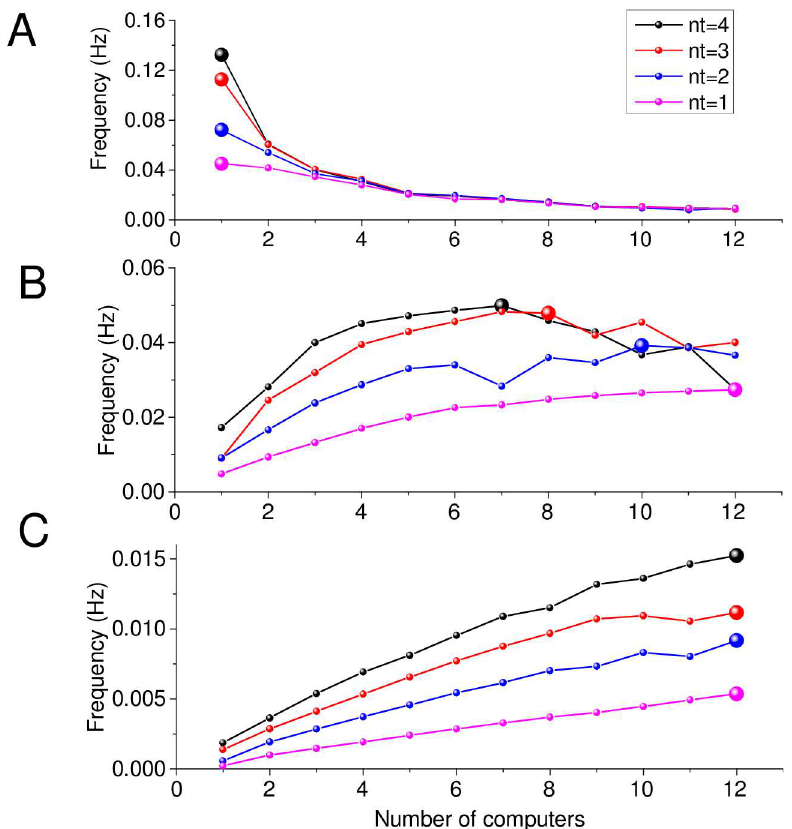
Fig 2. Tests to determine optimal performance. (A) Performance indicatorversus number of computers: examplesfor small i - and e - networks (100 cells). Ordinate, frequency(1 / runtime). Large balls, the optimal numberof computers; n t , the number of cores per processor. Scalabilitytests were performed on a cluster of 12 computers, each with 4-core processors. (B-C) Similar tests as in (A) for a medium (B, 1000 cells) and larger (C, 4000cells) network. Other notationsas in